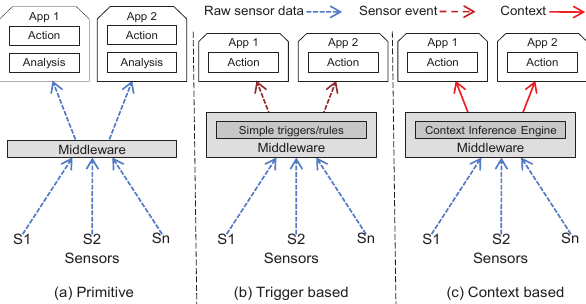
Figure 1: Evolution of building middleware systems based on sup- port for processing sensor data. (a) primitive middleware